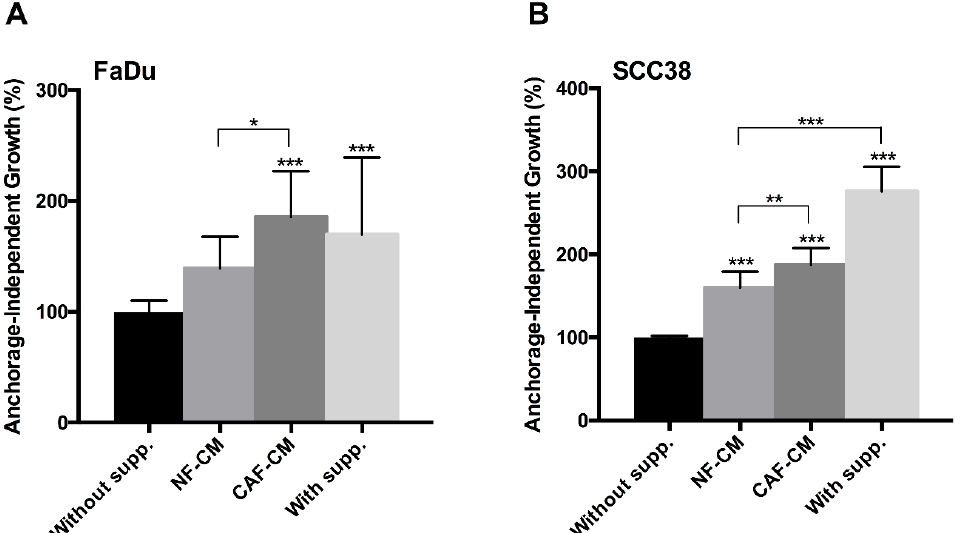
Figure 2. Effect of fibroblast-CM on anchorage-independent growth of HNSCC cells. ( A ) FaDu and ( B ) SCC38 cells were seeded in plates coated with Poly(2-hydroxyethyl methacrylate) (polyHEMA) and grown in non-supplemented medium, CM from NFs, CM from CAFs, or supplemented medium. Cell proliferation was estimated by tetrazolium-based MTS assay after 4 days. Data were normalized to the absorbance at day 0 and relative to control (non-supplemented) cells. All data were expressed as the mean ± SD of at least three independent experiments performed in quadruplicate. *** p < 0.001, ** p < 0.01 and * p < 0.05 by Holm-Sidak’s multiple comparisons test.